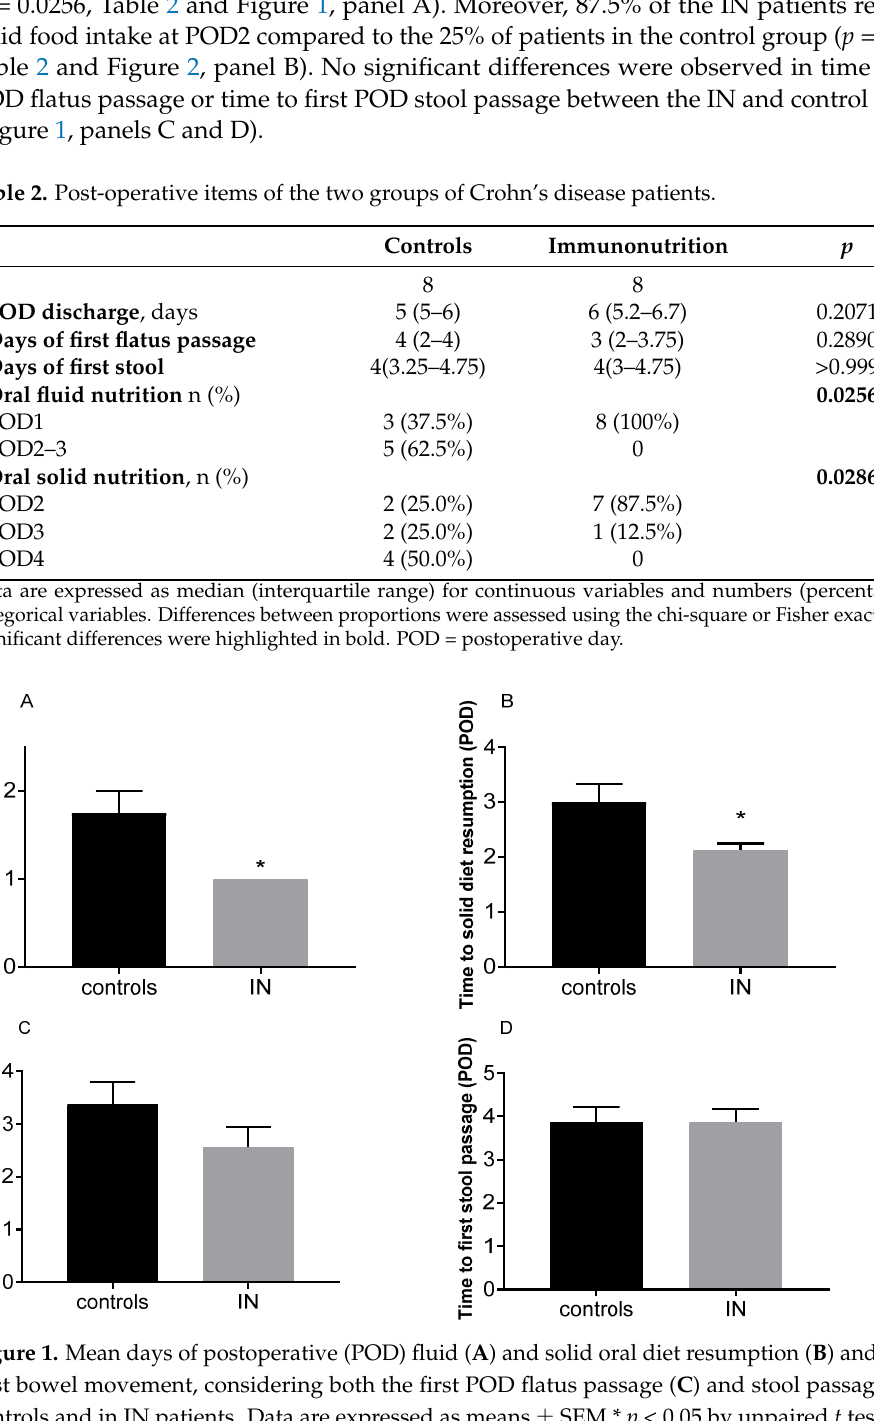
Figure 2. Mean levels of Advanced Glycated End-products, AGEs ( A ) and of Tight junction protein- 1 (TJP1) gene expression ( B ) in mucosal samples from CD patients in the control and IN groups. * p < 0.05 by unpaired t test. UA = Arbitrary Unit. While we did not observe differences in the plasma levels of both AGEs and AOPPs comparing the two groups, the amount of AGEs in tissue samples was significantly lower in the IN-group compared to controls (26.83 ± 3.06 vs. 39.59 ± 4.41 UA/mg of proteins; p = 0.0321) (Table 3 and Figure 2, panel A).